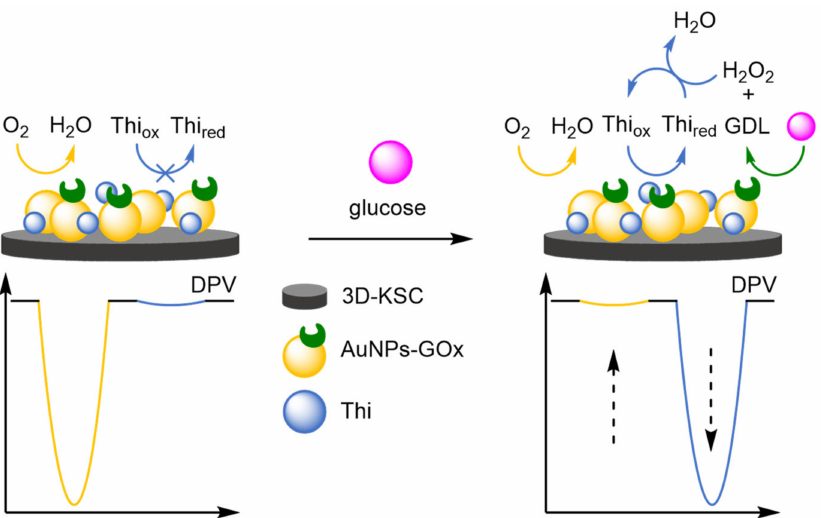
Figure 42. Schematic representation of a glucose oxidase-based biosensor for the detection of glucose. Song et al. have utilised alternative biocompatible material in the pursuit of a glucose biosensor (Figure 43) [132]. Polymerisation of Thi and terephthalaldehyde created an electroactive Schiff base polymer (SBP) that had two separate redox peaks at − 50 mV and − 200 mV. Co-immobilisation of the SBP and GOx onto a GCE created the biosensor, with O 2 reduction at the electrode with a peak at − 375 mV utilised as the second signal for ratiometric analysis. On addition of glucose, the O 2 peak decreases as the O 2 is used to re-oxidise GOx instead of being reduced at the electrode surface. The biosensor displayed a comparable dynamic range from 0.82 µ M to 4.0 mM and an improved LOD of 0.27 µ M. The electrode displayed excellent reproducibility with an RSD of 0.51% across 10 electrodes, and an intra-assay RSD of 0.34% (n = 6). The flexibility of SBP was integral to its development as a wearable biosensor, which displayed good retention of LOD at 2.4 µ M and a dynamic range of 7.2 µ M–4 mM. The group further developed a covalent organic framework using an ammonia-aldehyde condensation reaction to form a flexible surface with two pore sizes [133]. Immobilisation of GOx and microperoxidase 11 into the dual pores allowed for ratiometric electrochemical detection of glucose.